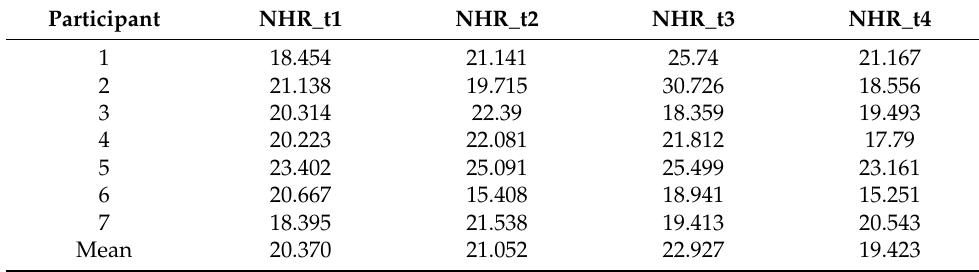
Table 11. HNR (Db) individual and mean measurements at four assessment time